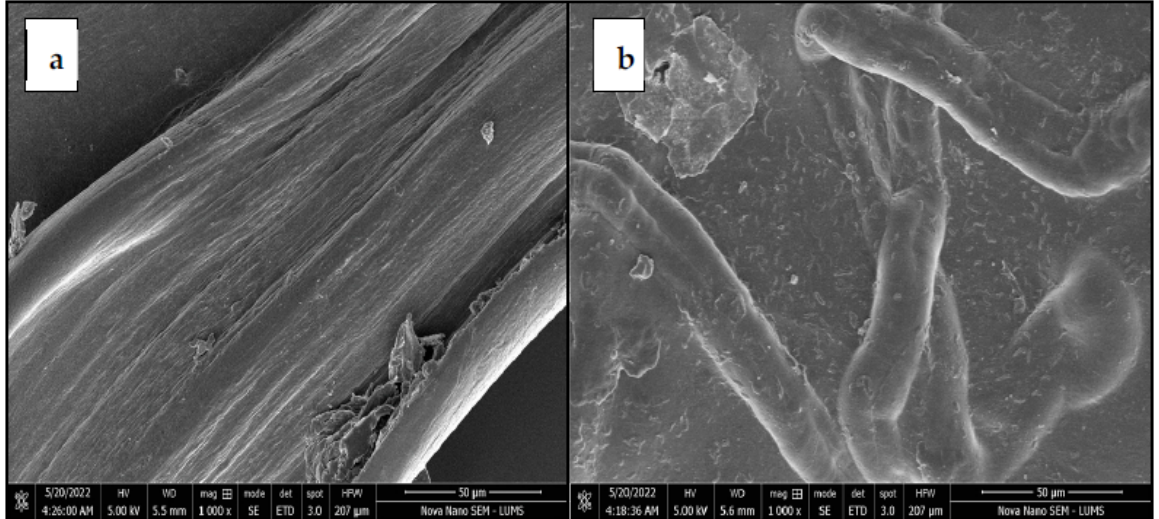
Figure 4. ( a ) SEM image for hydrogel fiber without reinforced fibers ( b ) SEM image for hydrogel with cotton fibers as reinforcement. with cotton fibers as